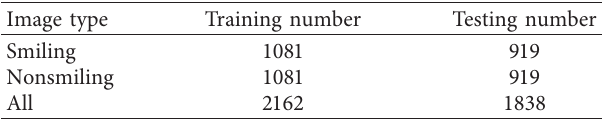
Figure 4: Communication between the HTTP client and HTTP server Table 1: A number of sample images used for the smiling and nonsmiling training reference models.